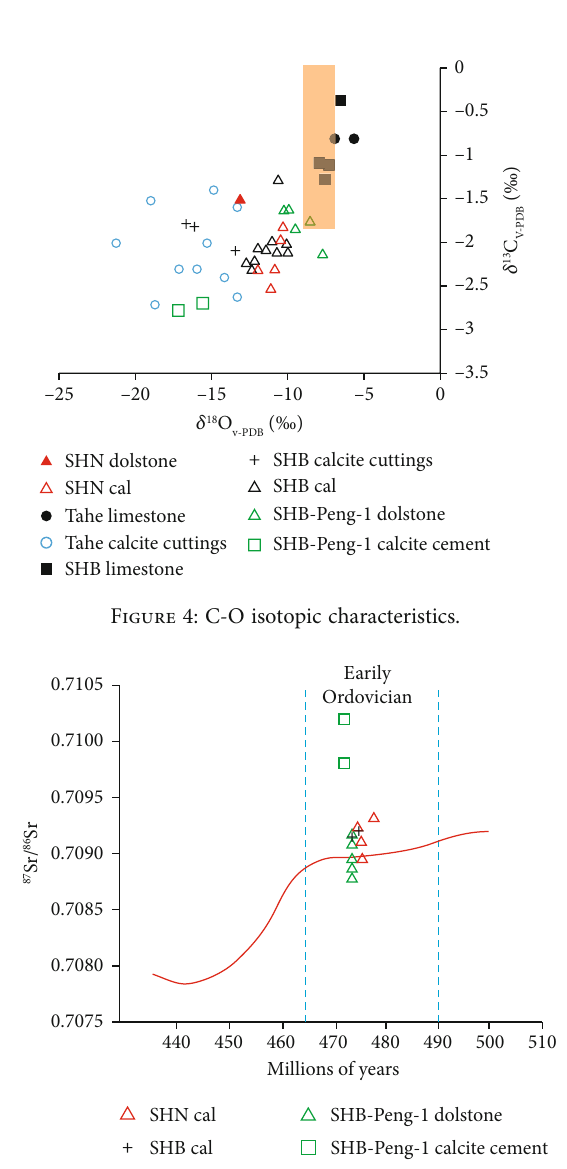
Figure 5: Sr isotopic